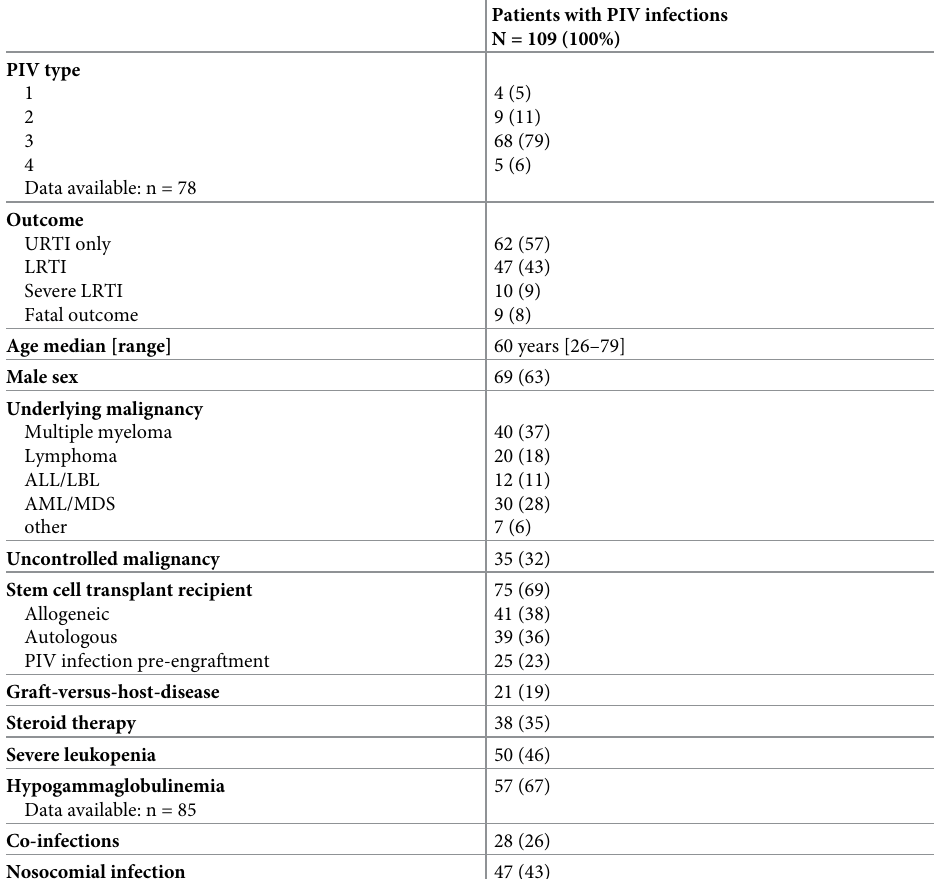
Table 1. Clinical